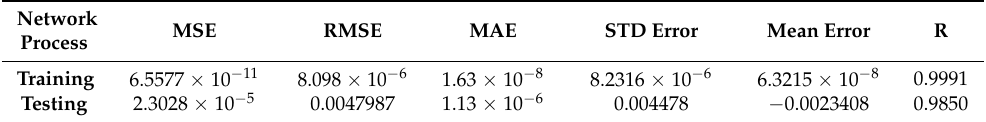
Table 2. Modeling performance